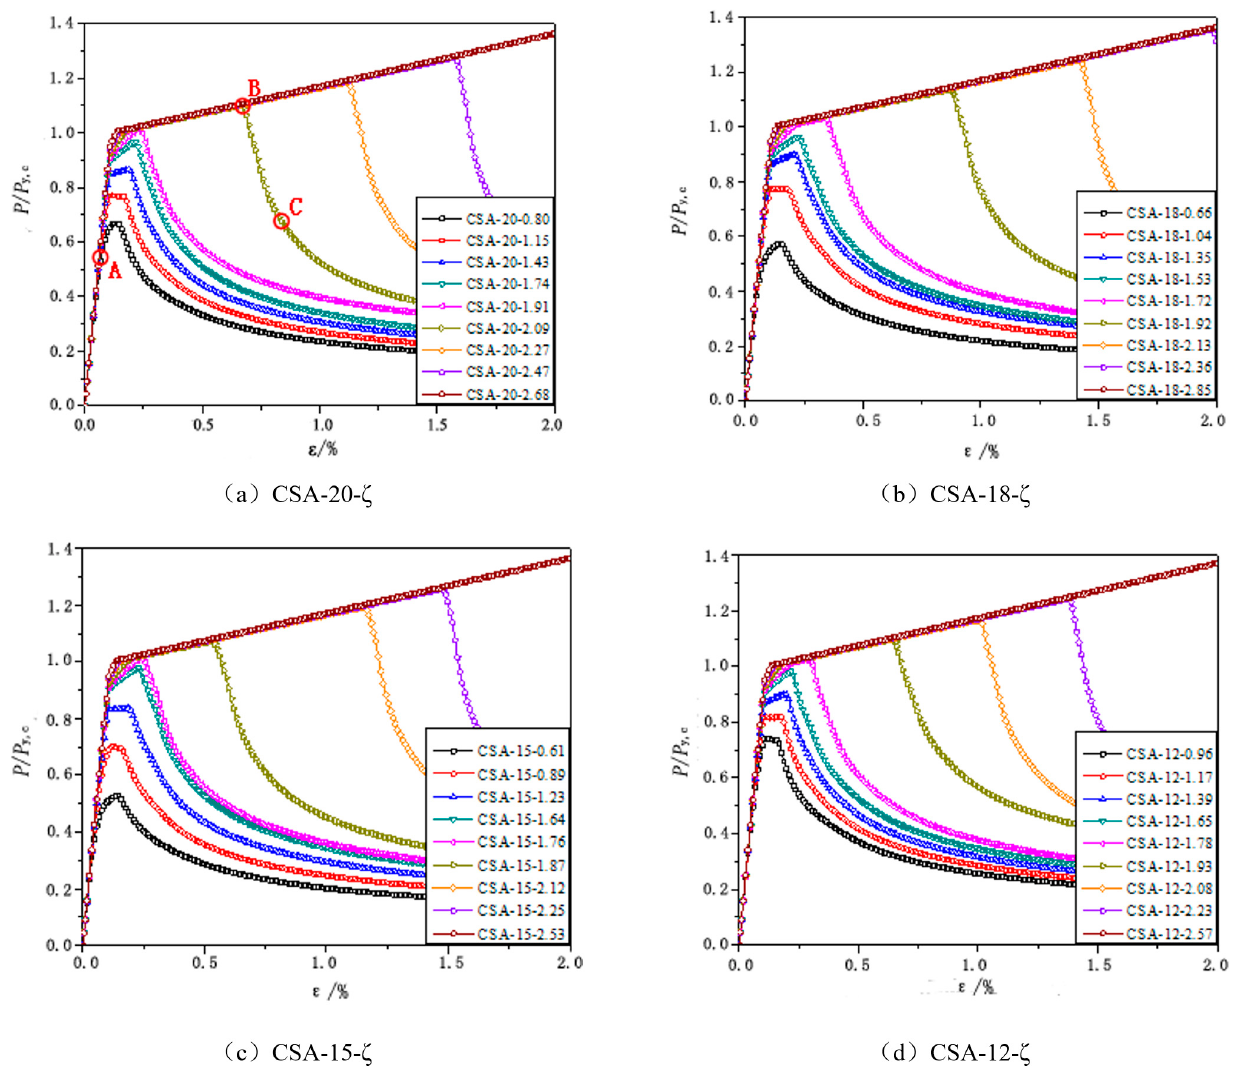
Figure 7. Axial load-displacement curves for numerical examples No. 1, 2, 3, and 4, respectively.